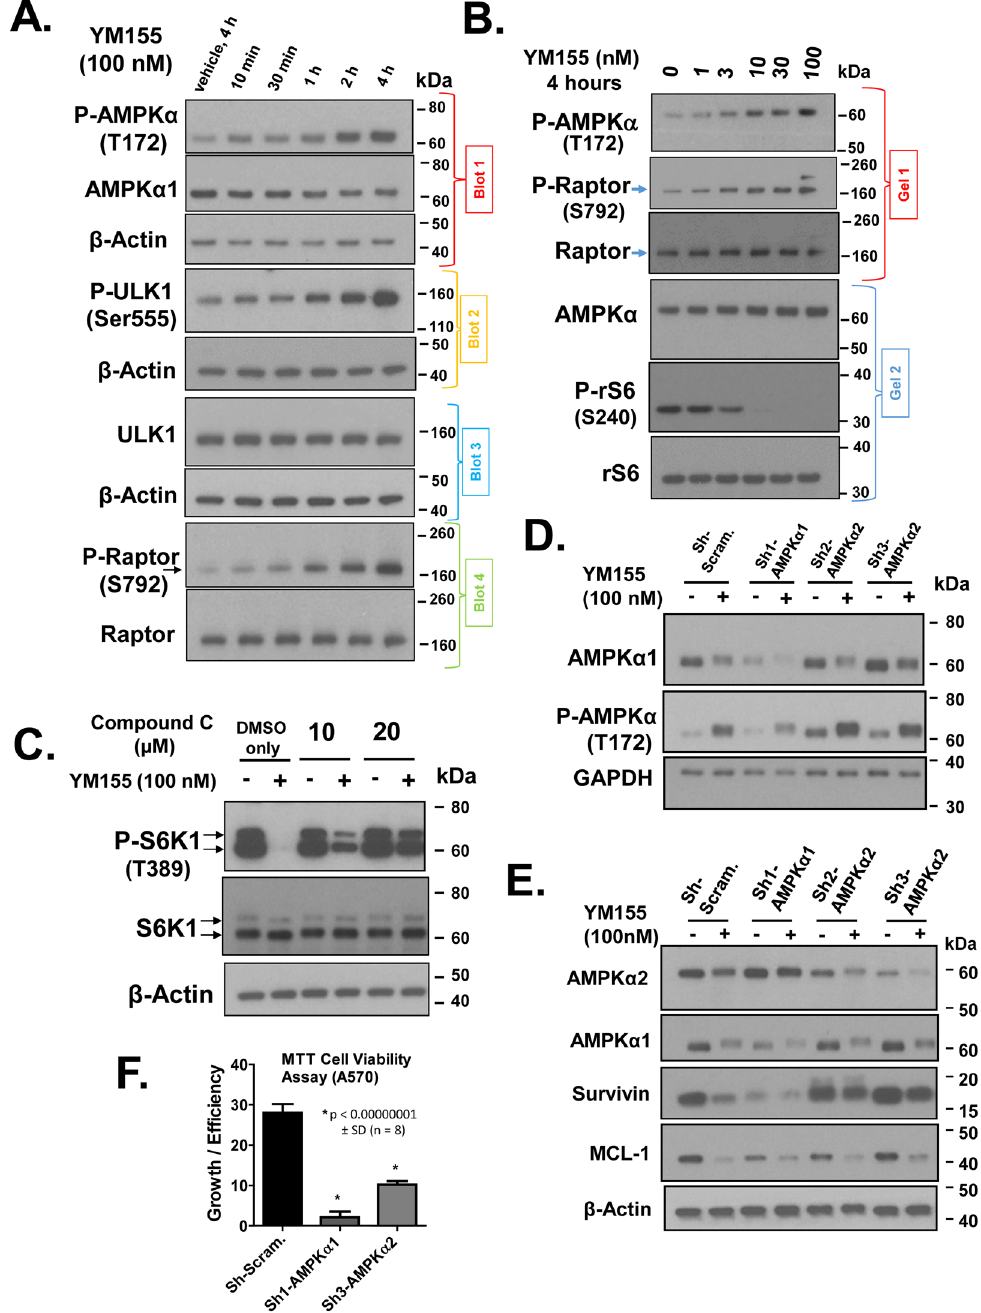
Figure 8. Role of AMPK in cellular responses to YM155. YM155 rapidly activates AMPK in PC-3 cells, and the AMPK inhibitor, Compound C, partially reverses the suppression of P-S6K1 by YM155. ( A ) PC-3 cells were treated with 100 nM YM155 for various early times (from 10 min to 4 h), and changes in the expression of P-AMPK α (T172), AMPK α , P-ULK1(S555), ULK1, P-Raptor (S792), and Raptor were assessed by Western blot. ( B ) PC-3 cells were pre-treated (30 min) with the AMPK kinase inhibitor Compound C or vehicle, followed by treatment with vehicle followed by 4 h treatment with YM155 or vehicle at the indicated drug concentrations, and P-S6K1(T389) and S6K were analyzed by Western blotting. ( C – F ) AMPK α 1 and AMPK α 2 were stably silenced in PC-3 cells by lentiviral-mediated shRNA transduction for 5 to 7 days as described in Materials and Methods. Stably transduced cells were treated for 4 h with 100 nM YM155 or vehicle for 4 h, and the resulting cell lysates were subjected to Western blot for expression of the various protein shown, such as Survivin, Mcl-1, S6K1, PS6K1(T389) P-rS6 (S240) and P-4E-BP1(S65). Knockdown of AMPK α 1 or AMPK α 2 by lentiviral-mediated shRNA transduction each led to loss of reduced P-S6K1(T3489) changes in P-rS6 (S240) relative to rS6 ( E ) and cell growth/viability by MTT assay ( F ). Relative changes in cell growth/viability of transduced cells by MTT assay as described in Material and Methods. Unless indicated on the figure, each group of blots represents data obtained from a single gel and experiment. Results shown are representative of 2 to 3 independent